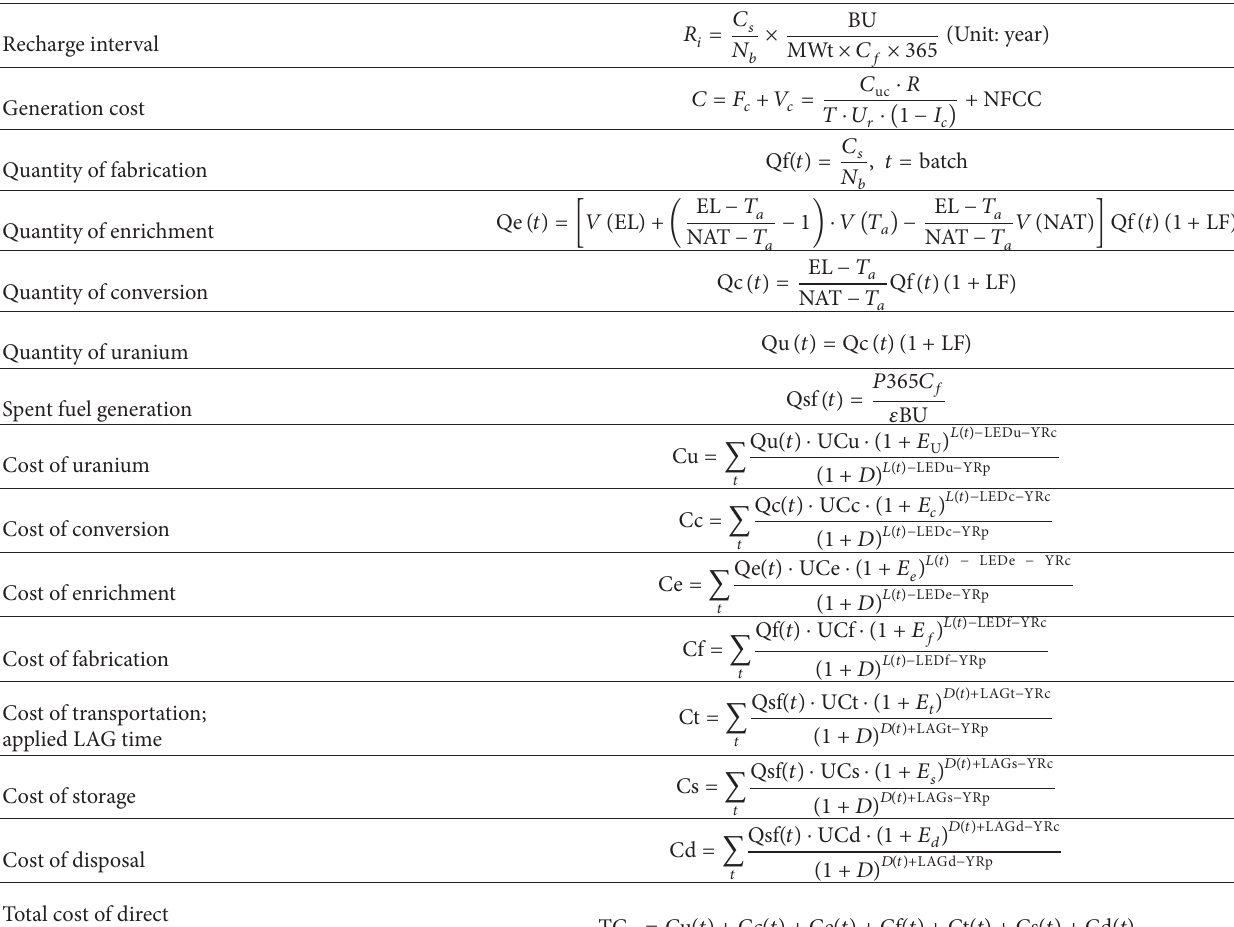
Table 7: Equations for the direct disposal